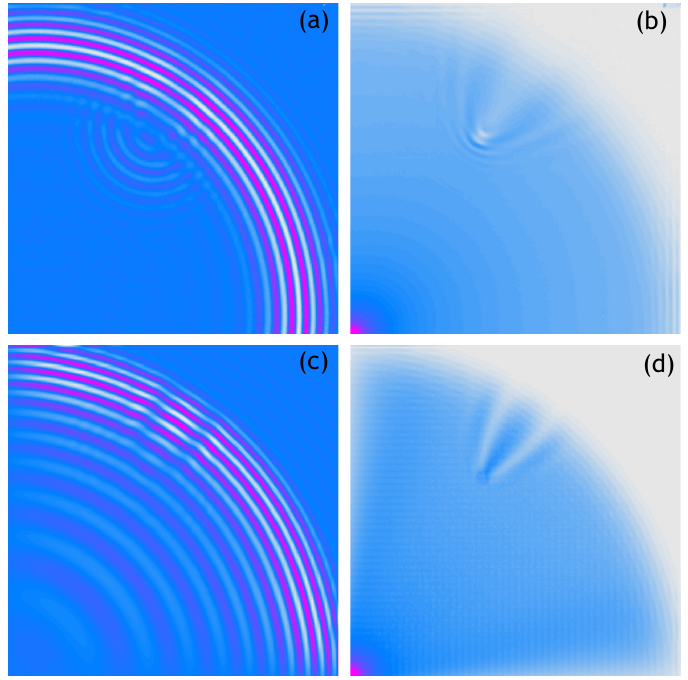
Figure 3. Wave propagation velocity patterns registered at 0.8 ms with 250 × 250 mesh grid, ( a ) Ex- perimental data, ( b ) RMS of experimental data, ( c ) Calculated data, ( d ) RMS of calculated